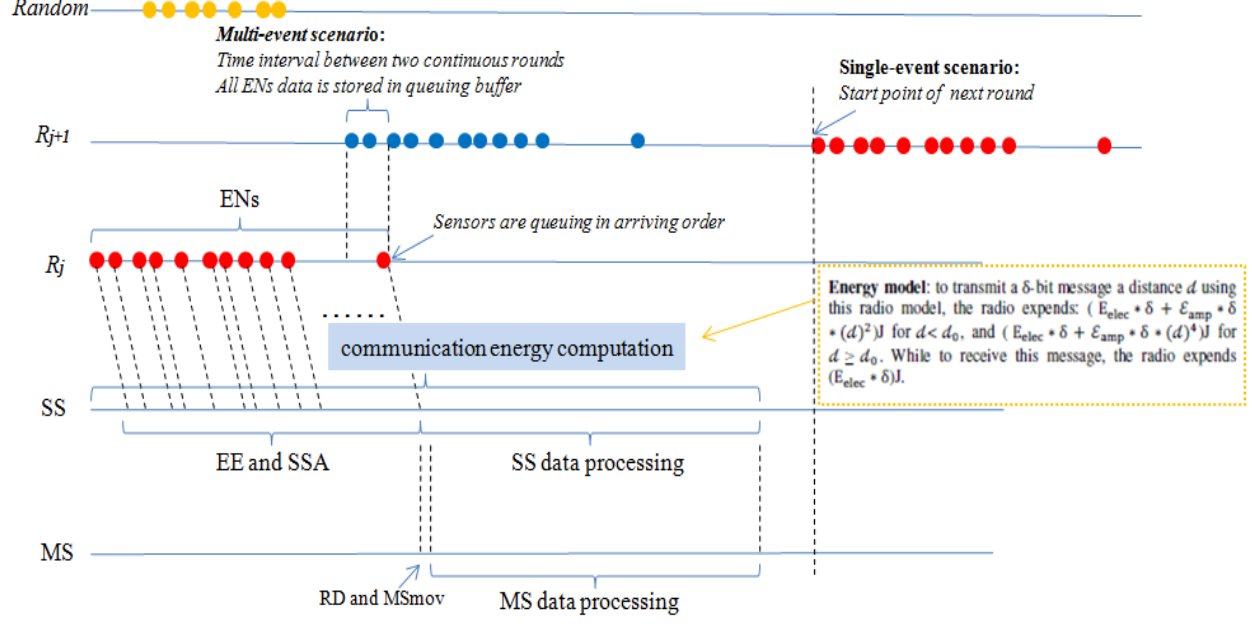
Figure 3. Processing map based on time